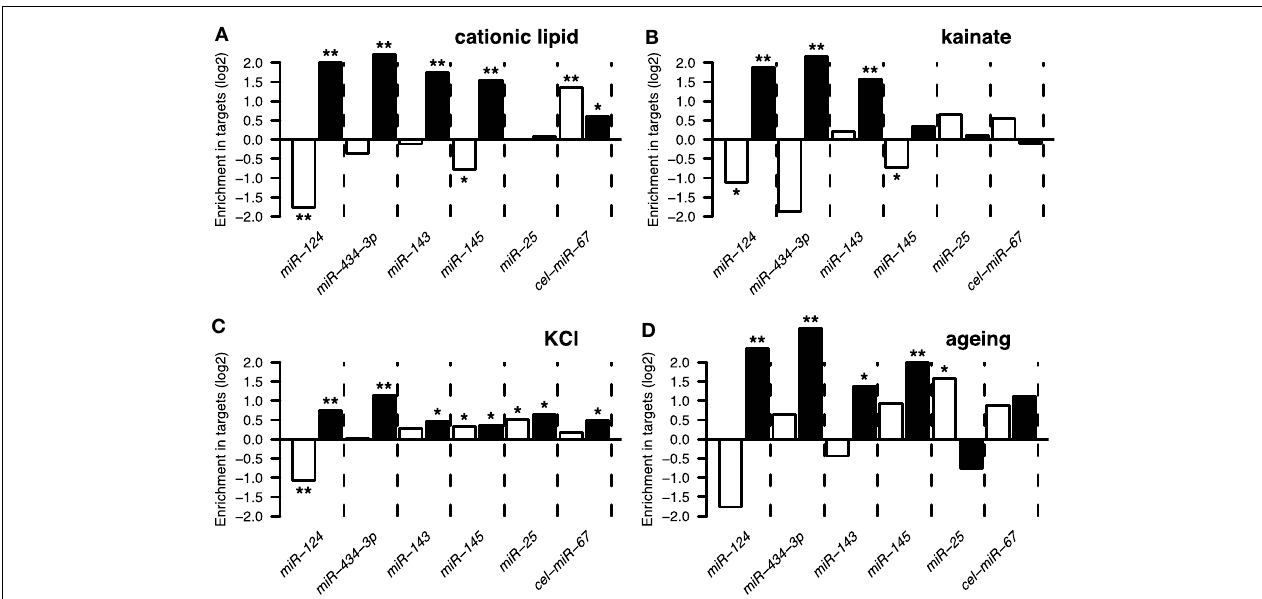
neuronal cultures with cationic lipid transfection reagent; (B) treatment of the brain with kainate; (C) treatment of primary neuronal cultures with KCl; (D) ageing of the human brain. A single asterisk indicates hypergeometric P < 0.05, double indicates P < 0.001.The set of 10,849 genes detected by Illumina microarrays (see Materials and Methods) in mock transfected and untransfected cultures was used as the universe for the hypergeometric